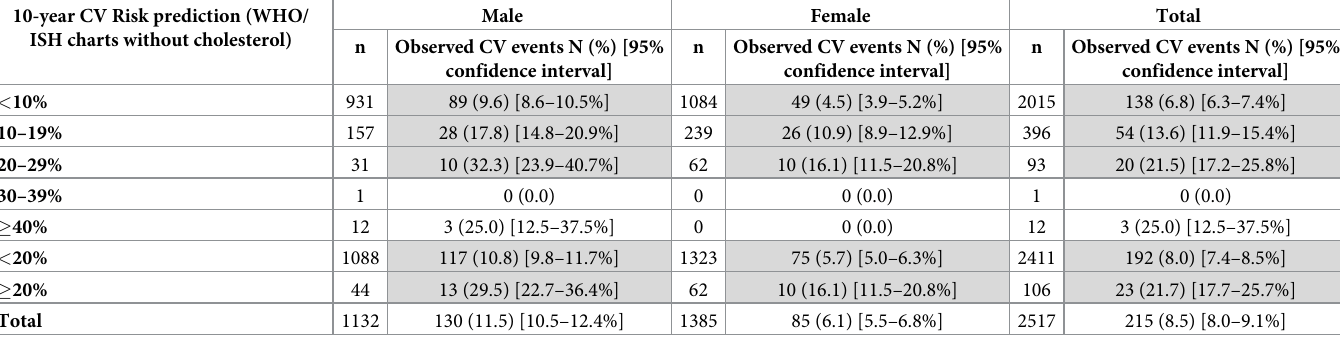
Table 5. Validation of WHO/ISH (SEAR B) risk prediction charts without cholesterol over 10 years. 10-year CV Risk prediction (WHO/ ISH charts without